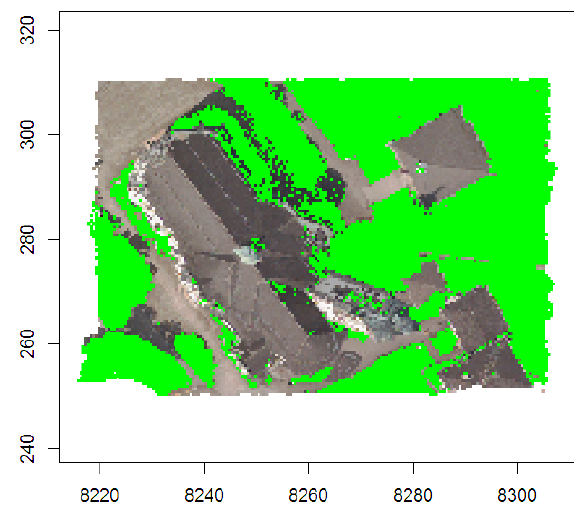
Figure 7. Orthophoto with detected and visualized vegetation classified as vegetation. The resulting orthoimage is depicted in Figure 7. The vegetated areas are visualized in green